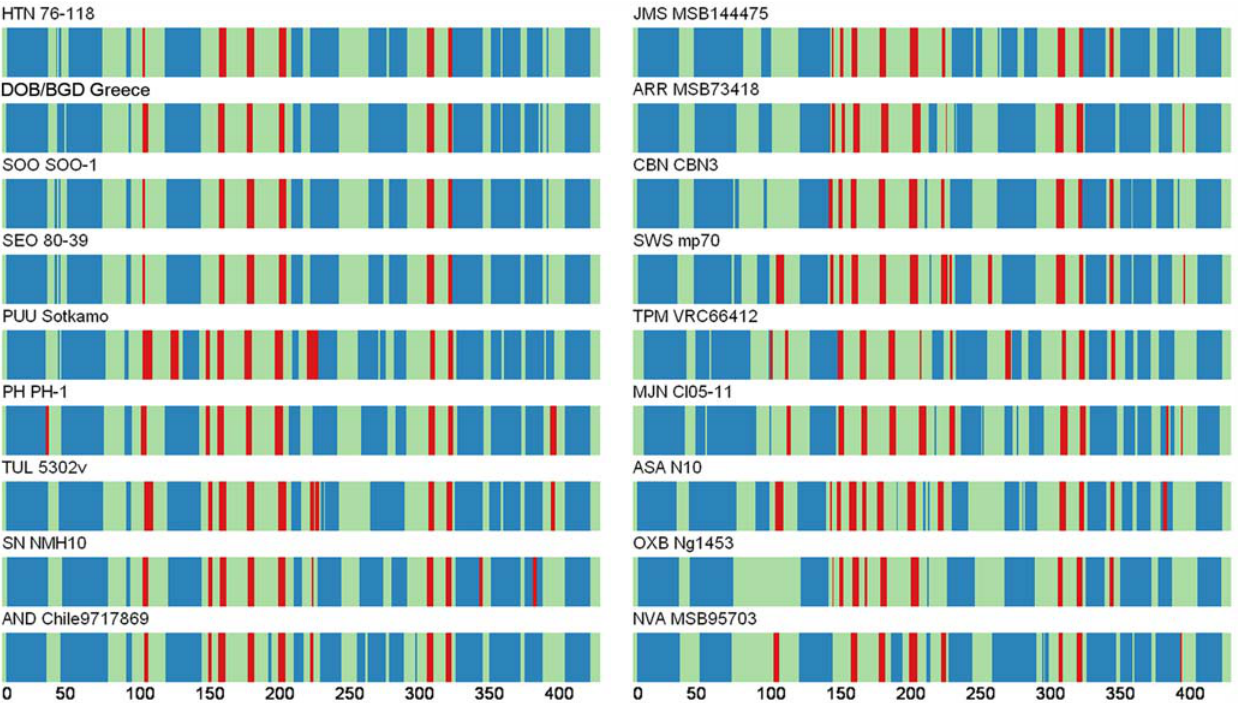
Figure 3. Comparison of consensus secondary structures of entire N proteins of NVA MSB95703 and representative hantaviruses, predicted using several methods, including HNN [ 20 ] , DSC [ 26 ] , PHD [ 42 ] , PREDATOR [ 16 ] and MLRC [ 18 ] at the NPS@ structure server [ 12 ] . N protein structures are shown for rodent-borne hantaviruses (left panel: HTN 76–118, DOB/BGD Greece, SOO SOO-1, SEO 80-39, PH PH- 1, PUU Sotkamo, TUL 5302v, SN NMH10 and AND Chile 9717869) and for hantaviruses harbored by shrews (right panel: JMS MSB144475, ARR MSB73418, CBN CBN-3, SWS mp70, TPM VRC66412, MJN Cl05-11) and moles (right panel: ASA N10, OXB Ng1453, NVA MSB95703). Blue bars represent a-helices, red bars b -strands, and green and orange indicate random coil and unclassified structures,